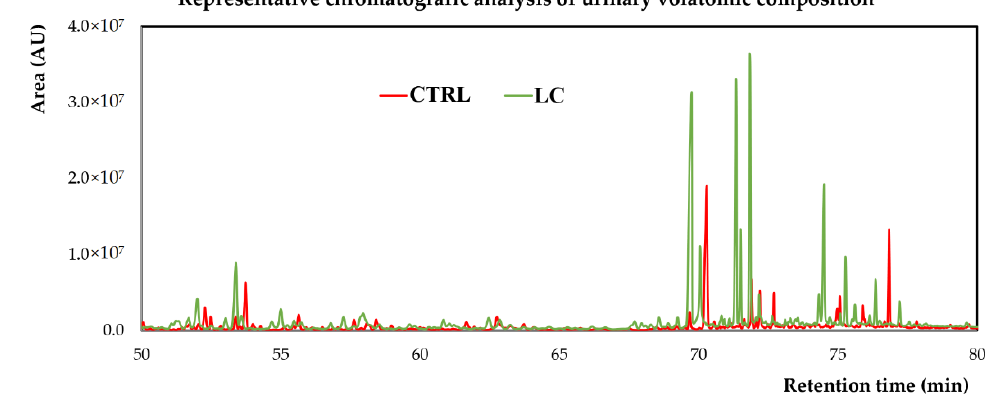
Figure 2. Representative chromatogram of urine sample from a control subject (CTRL) and a LC patient. AU—arbitrary units.